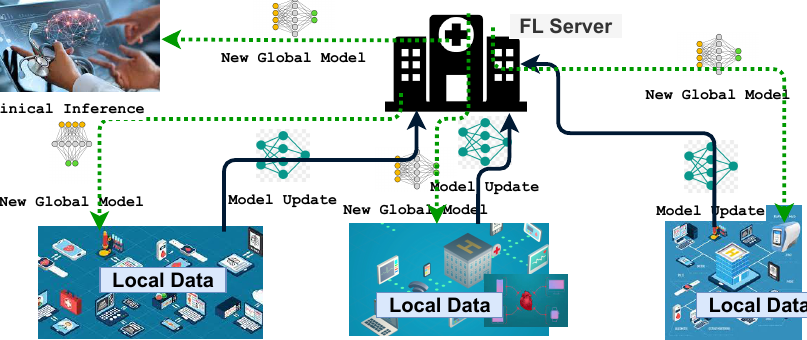
Figure 11. Federated learning in smart healthcare with an edge-computing-enabled